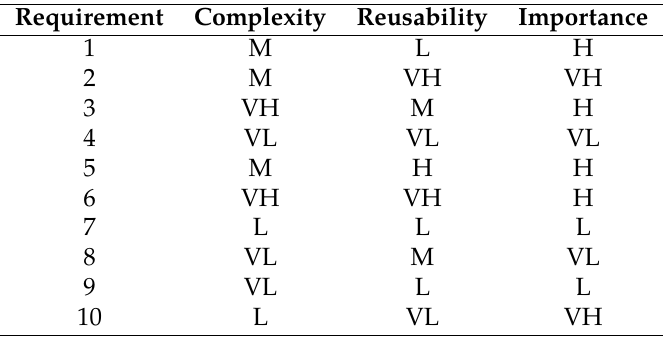
Table 2: Example of one of the experts’ opinions matrices used in the proof of